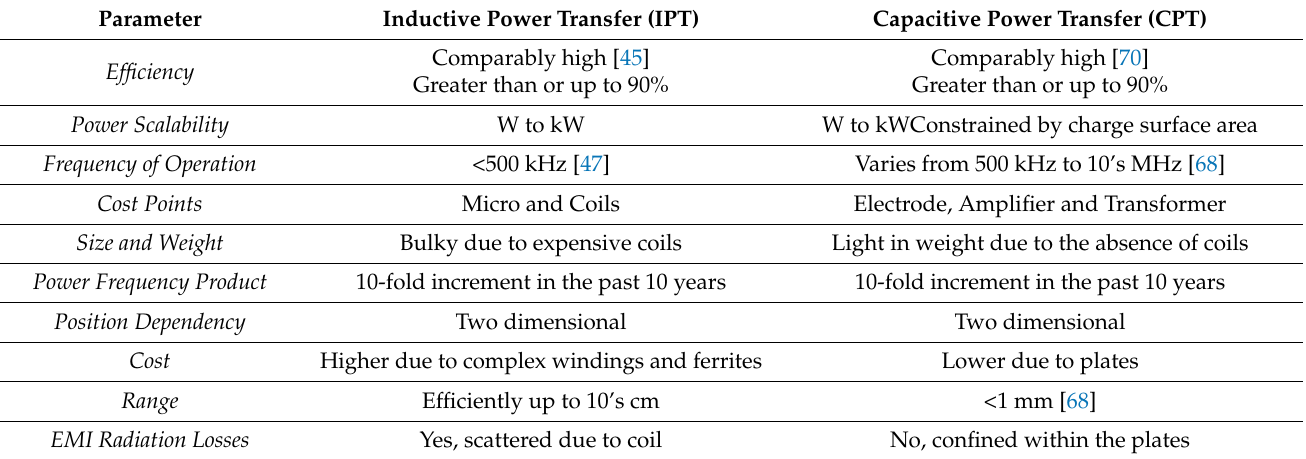
Table 4. Various practical parameters based on the Inductive and capacitive power